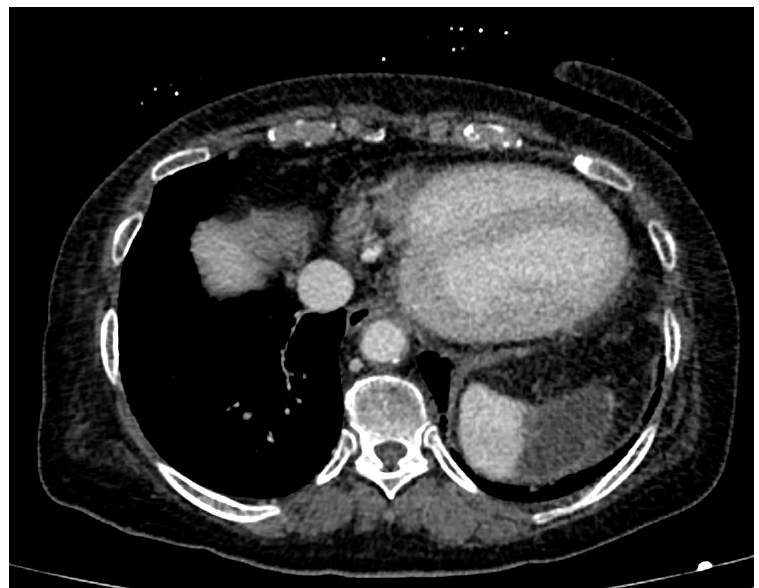
Figure 3. CT angiography, coronal planes, portal phase. Focal ischemia of the left renal parenchyma may be noted in the lower polar location.